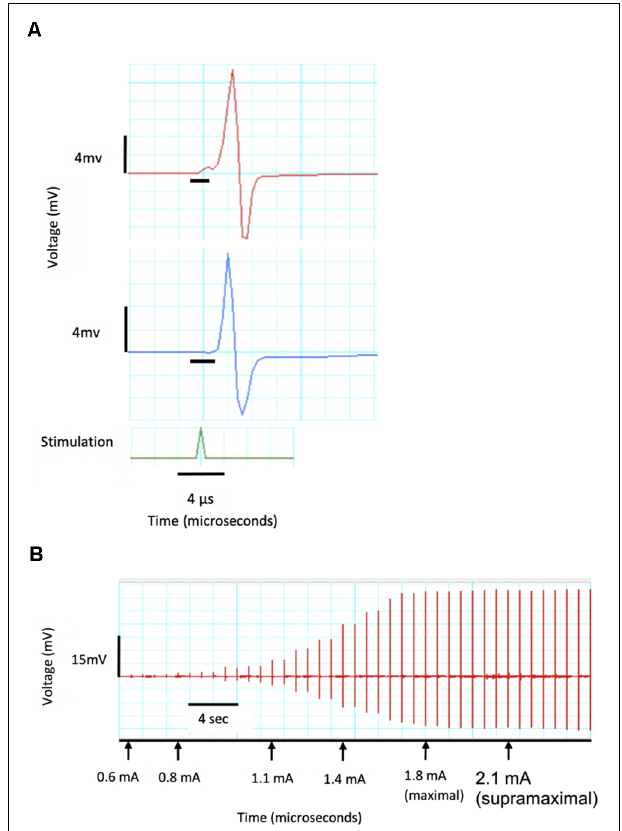
FIGURE 3 | CMAP recordings demonstrating a current response test from a single channel. (A) Recording of two CMAPs with peaks of 8.5 and 11 mV as well as a delay of 0.03 and 0.02 µ s which are identified by the black horizontal crossbars. (B) Current response curve showing threshold CMAP at a stimulating current of 0.6 mA, maximal response at 1.8 mA and 120% maximal (supramaximal) response at 2.1 mA and used in all further CMAP tests.